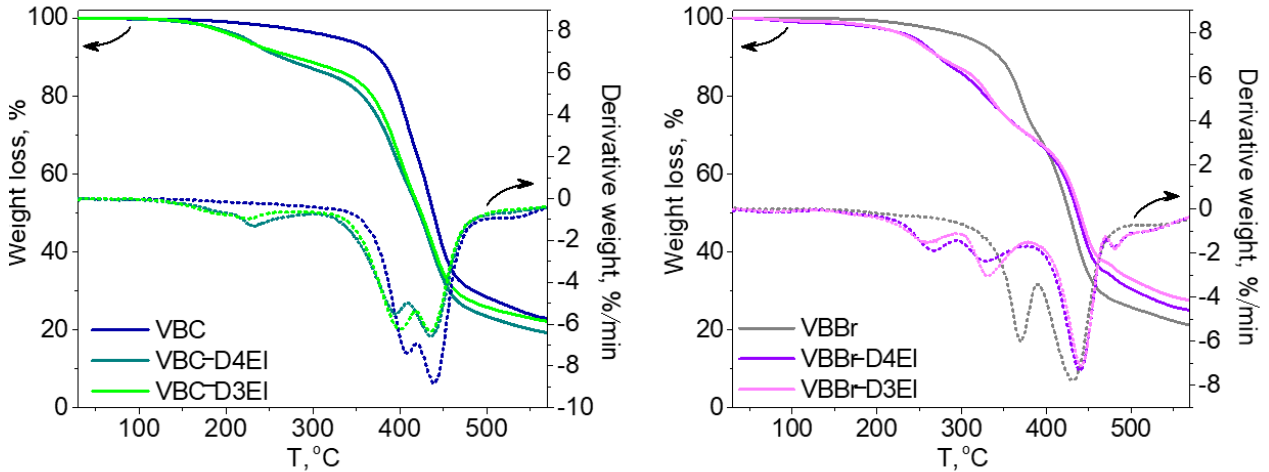
Figure 4. TG and DTG curves of unmodified and modified copolymers: ( a ) VBC and ( b ) VBBr with D3EI and D4EI.